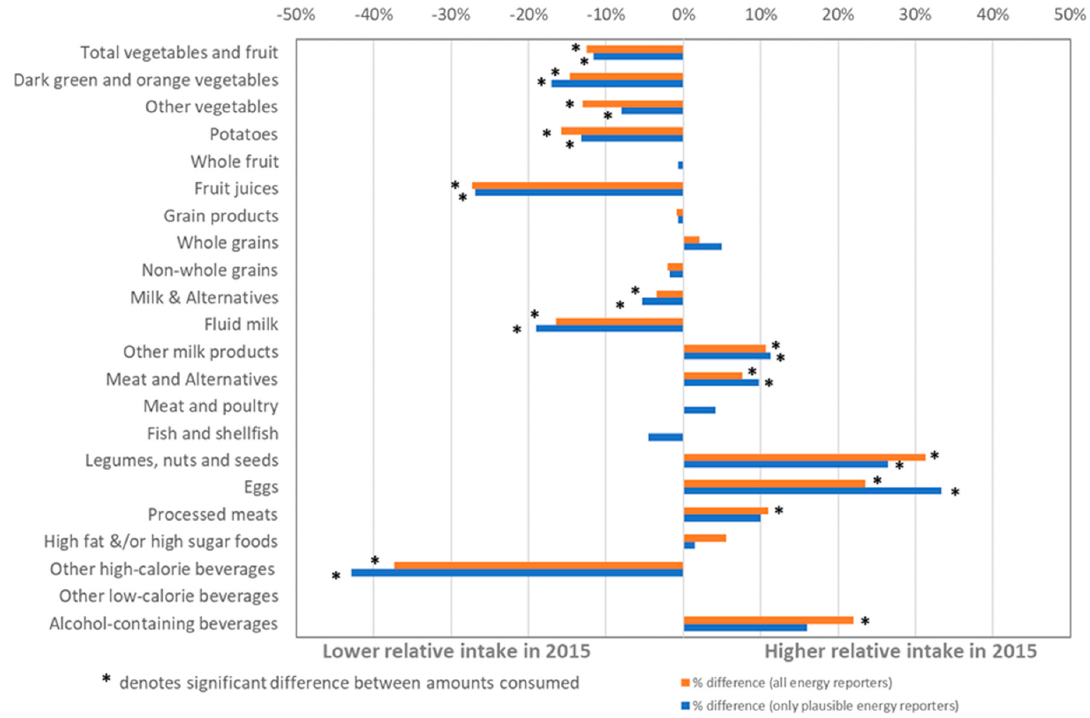
Figure 1. Relative percent (%) change in the mean daily intakes of foods among Canadians age 2 years and older 1 between 2004 and 2015. From 2004 to 2015, Canadians reported consuming, on average, approximately 15 and 17% fewer dark green and orange vegetables among plausible reporters and among all energy reporters, respectively. Over the same time period, Canadians reported consuming 8% and 13% fewer “other” vegetables among plausible reporters and among all energy reporters, respectively. Average intake from alcohol-containing beverages estimated for respondents aged 13 years and older only.